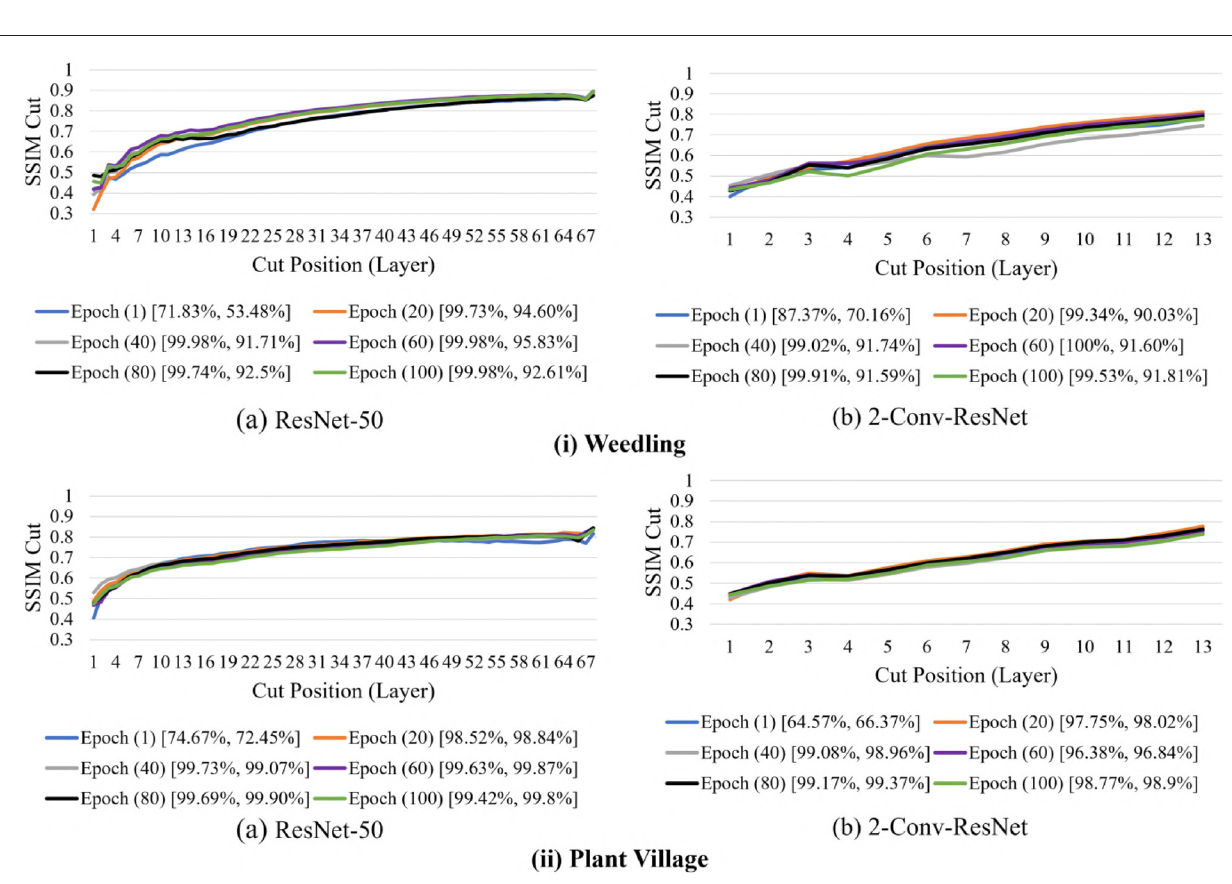
the capacity of the model. As a result, the training of the smaller models can be stopped before it is optimized (Caruana et al.,